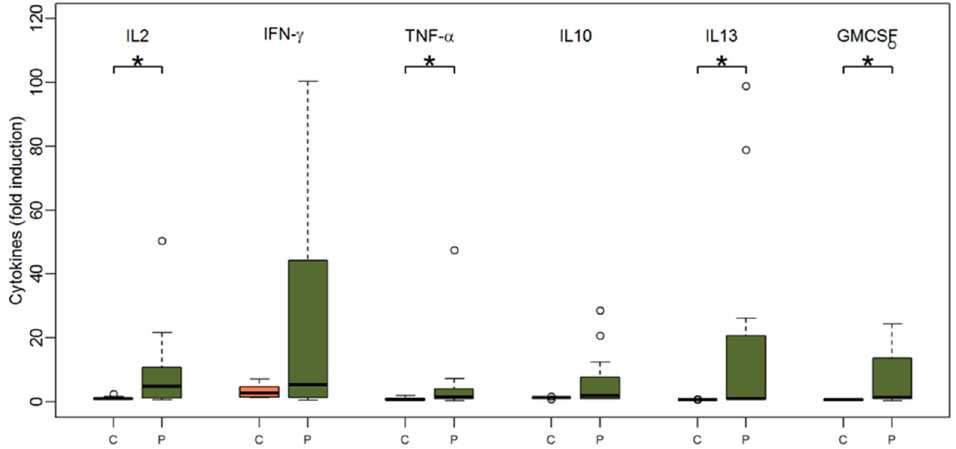
Figure 2. Boxplots showing the median and distribution of cytokines as detected by Luminex assay at baseline before vaccination for healthy controls (orange) and patients (green) after stimulation with TBE antigen. Asterisk marks significant p -value (IL2: p = 0.03; TNF-alpha: p = 0.03; IL13: p < 0.001; GM-CSF: p = 0.01).